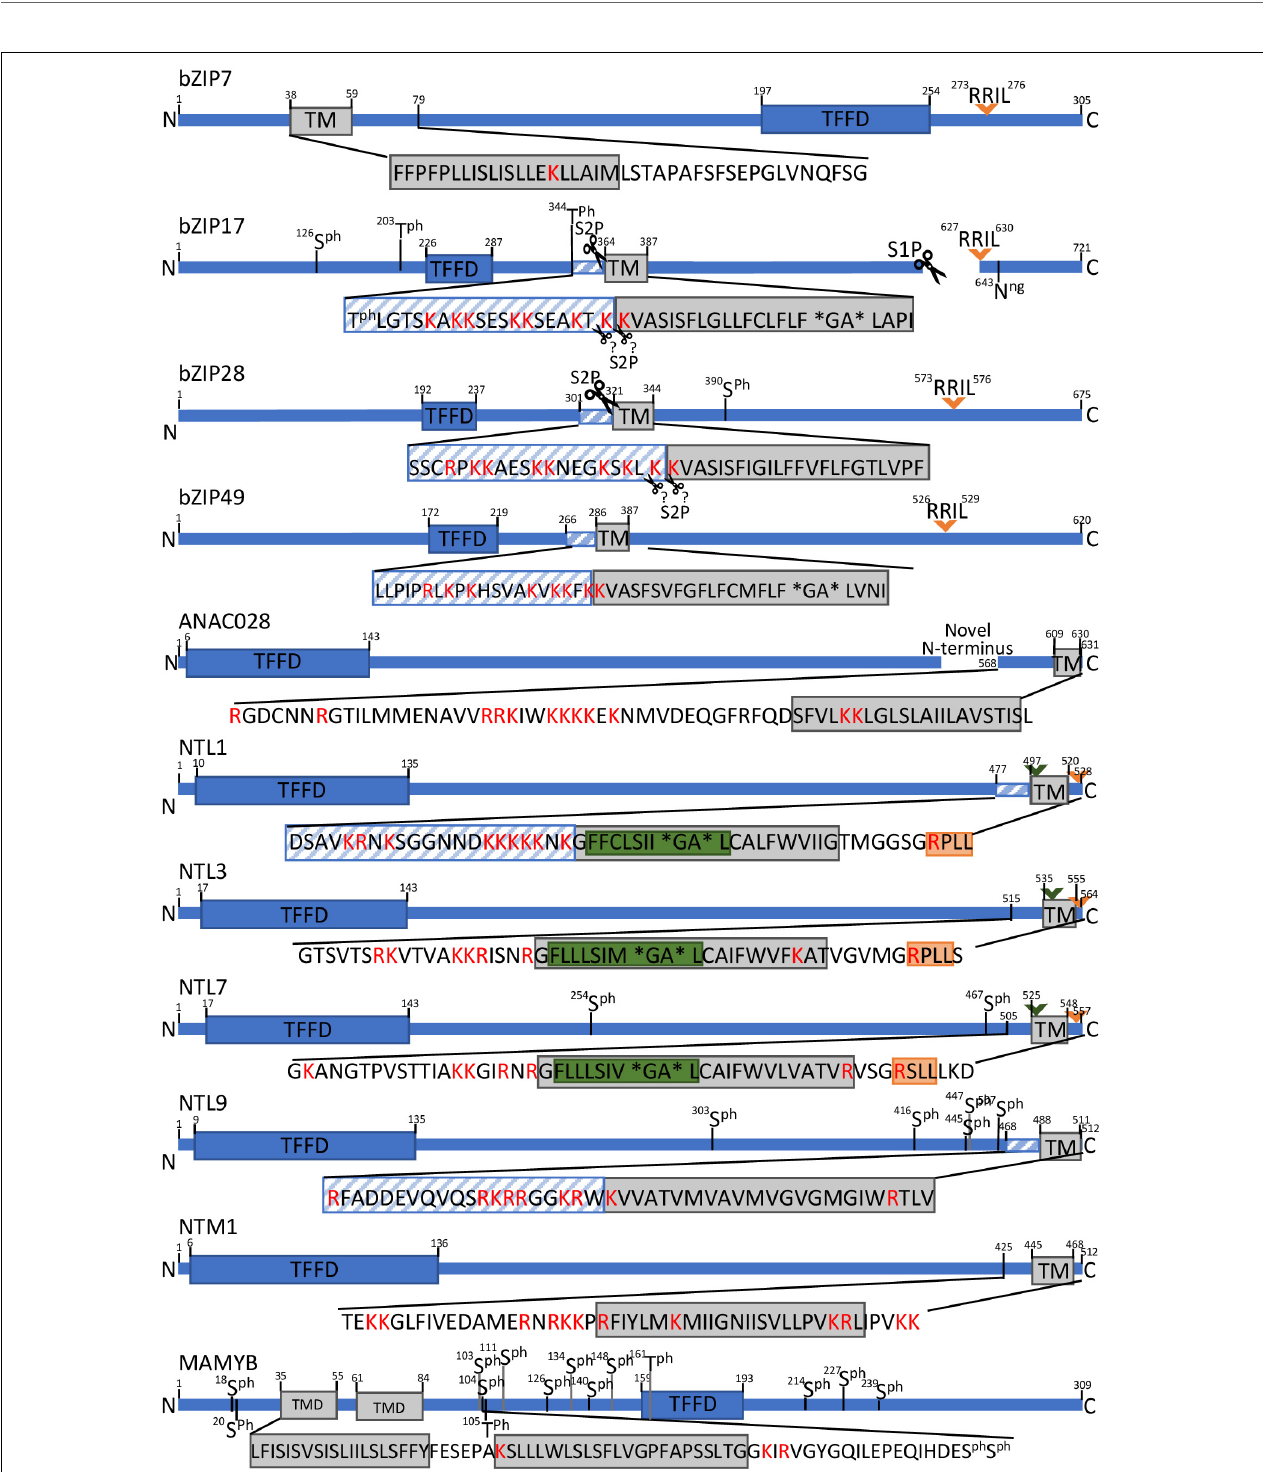
FIGURE 2 | Schematic presentation of protease recognition motifs and structural features indicative of RIP activation for a selection of MB-TFs. Predicted rhomboid recognition sites (LxLSIxGA) are indicated in green and (predicted) SIP recognition sites (Rx[LIT][KL]) in orange. Diagonal blue stripes mark TMD-neighboring regions that are significantly (corrected P value < 0.05) enriched for positive amino acids (R and K. lysine and arginine) and scissors indicate known or predicted cleavage sites. Asterisks specify helix-breaking residues. Ph. phosphorylated amino acid.